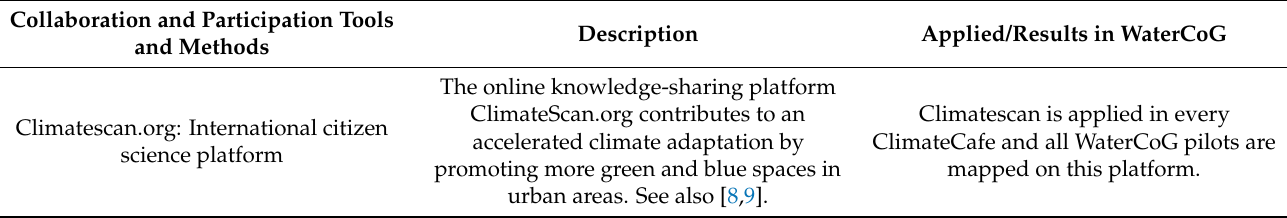
Table 2. Examples of tools applied in WaterCoG pilots to improve co-governance (including awareness raising and citizen sciences. In some countries, the number of documented facilitation tools in the context of the evaluation has been huge, but we limited the table to those tools that played a central role in the evaluated pilot processes. Collaboration and Participation